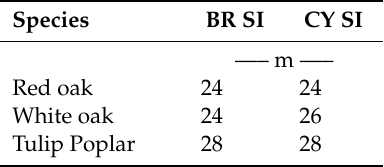
Table 1. Pre-mine site index (SI) height in meters at 50 years for red oak, white oak, and tulip poplar at the Birch River (BR) and Catenary (CY) mines in West Virginia.